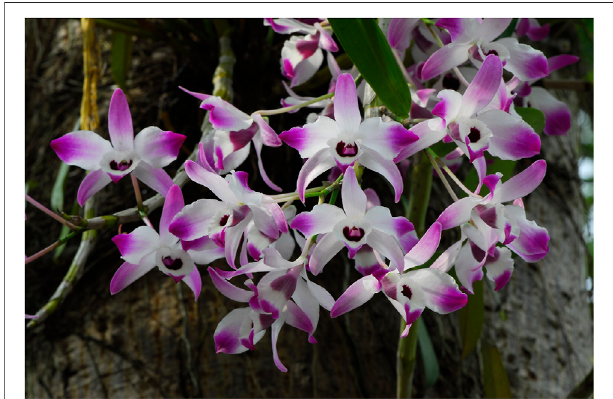
FIGURE 1 | The plant of Dendrobium nobile .